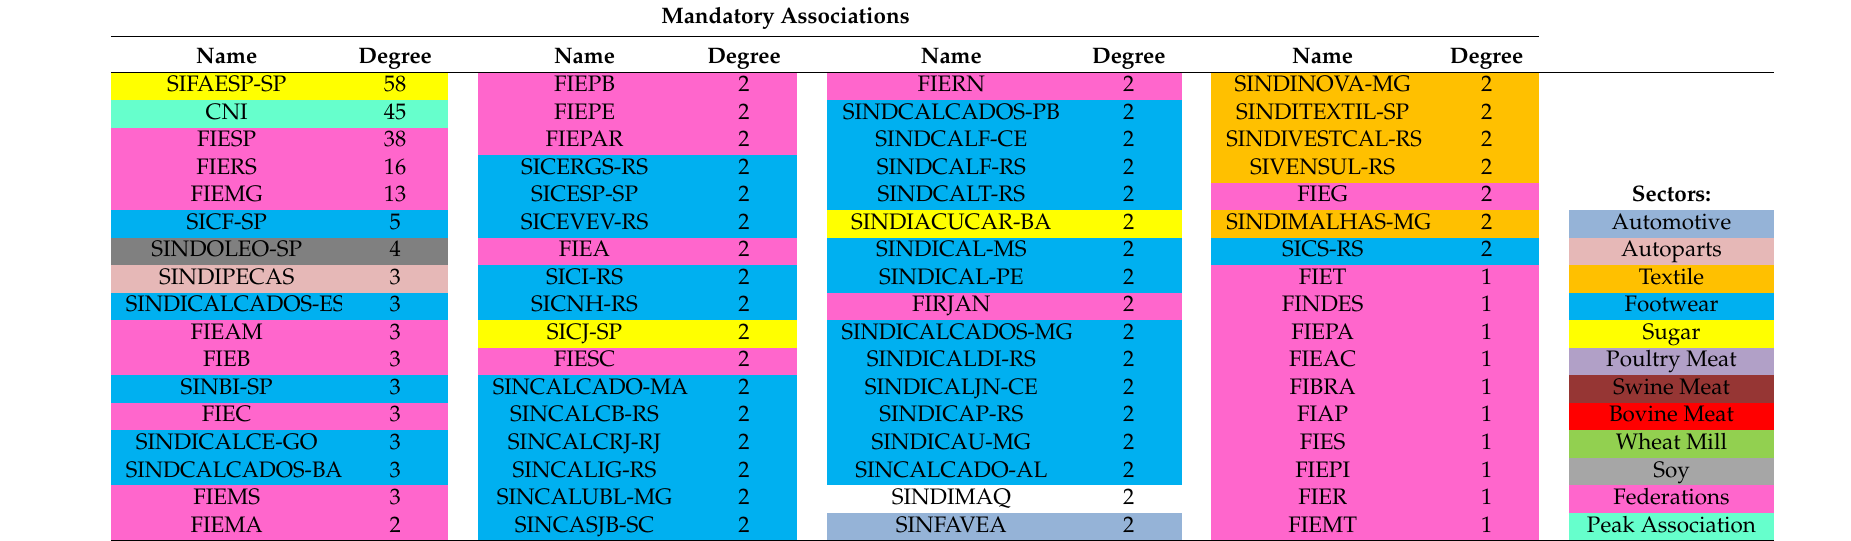
Note: The color represents different sectors. See color key